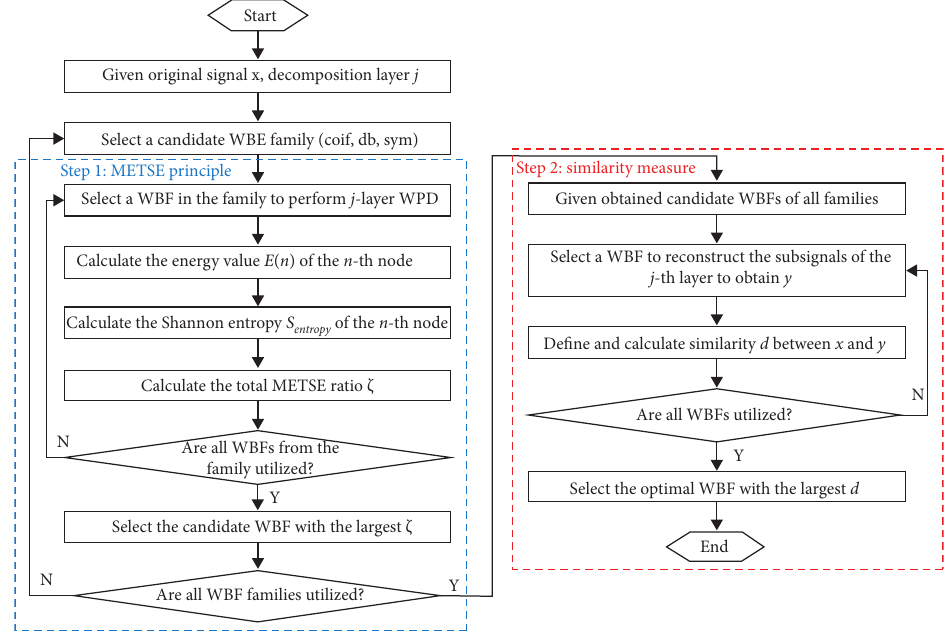
Figure 2: The proposed two-step principle of selecting the optimal